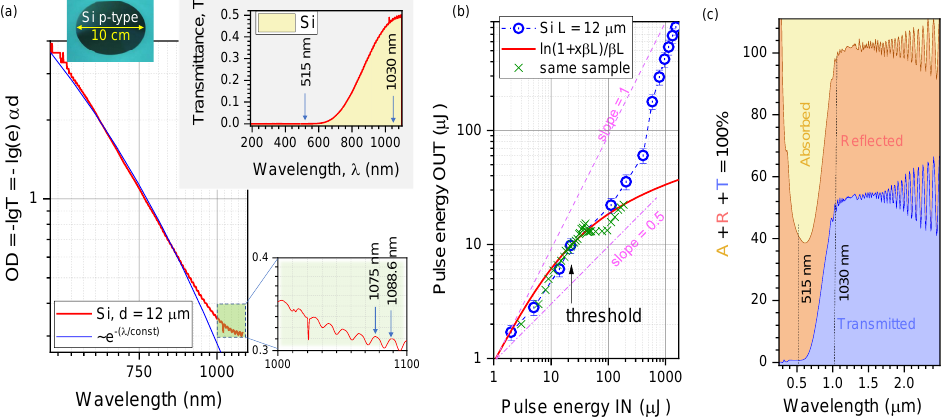
Figure 7. Transmission of micro-thin Si wafer. ( a ) Transmittance though d ≈ 12 µ m-thick Si wafer; note: log–log presentation for absorbance OD vs. λ . Thickness is determined from interference fringes: λ 1,2 are two adjacent maxima: d = 1/ [ 2 ( 1/ λ 1 − 1/ λ 2 ) n ] with n = 3.59 at a 1080 nm wavelength. ( b ) Transmittance at λ = 1030 nm through the L = 12 µ m-thick Si wafer. Each irradiation point was refreshed using a pre-programmed sample scan during the measurement. Focusing was with an NA = 0.14 objective lens into a focal spot of radius r = 0.61 λ / NA ≈ 4.49 µ m and a depth of focus 2 z R = π r 2 / λ > d . The single-pulse ablation threshold was recognisable (under the microscope) at E IN p = 22 µ J. The fit by ln ( 1 + x β L ) / ( β L ) is shown with two-photon absorption coefficient β = 858 cm/TW; x is the input pulse energy (intensity). The error bars are 15%. Cross markers show the data for the same sample and focusing conditions, only for the smaller step in energy between adjacent irradiation spots. ( c ) Portions (colour-coded) of the absorbed A , reflected R , and transmitted T power through the 12 µ m-thick Si slab measured using an integrating sphere (Lambda 1050 UV/VIS/NIR spectrometer;